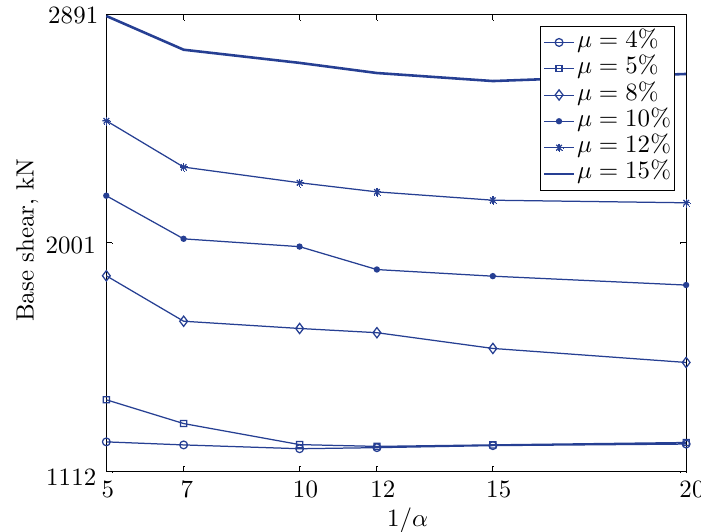
Figure 27. Maximum base shear for various isolation system parameters (Lucerne).